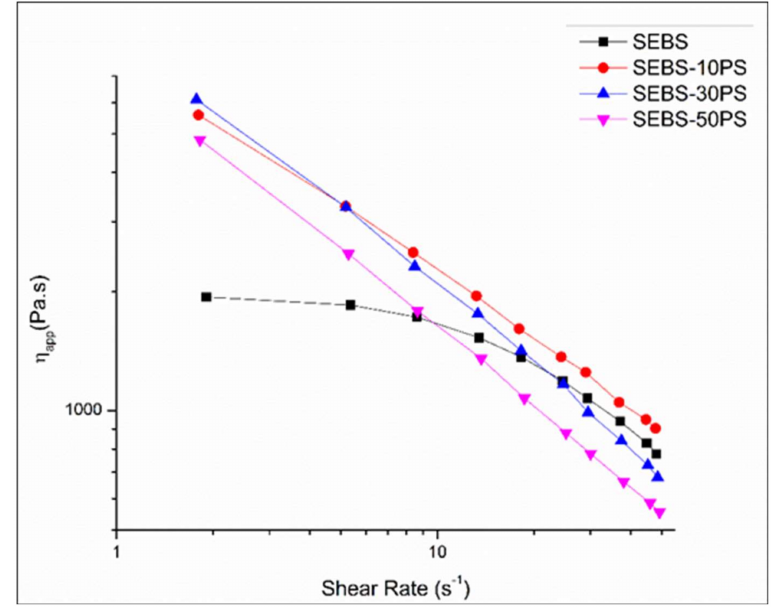
Figure 9. MiniLab relative rheological measurements for SEBS and